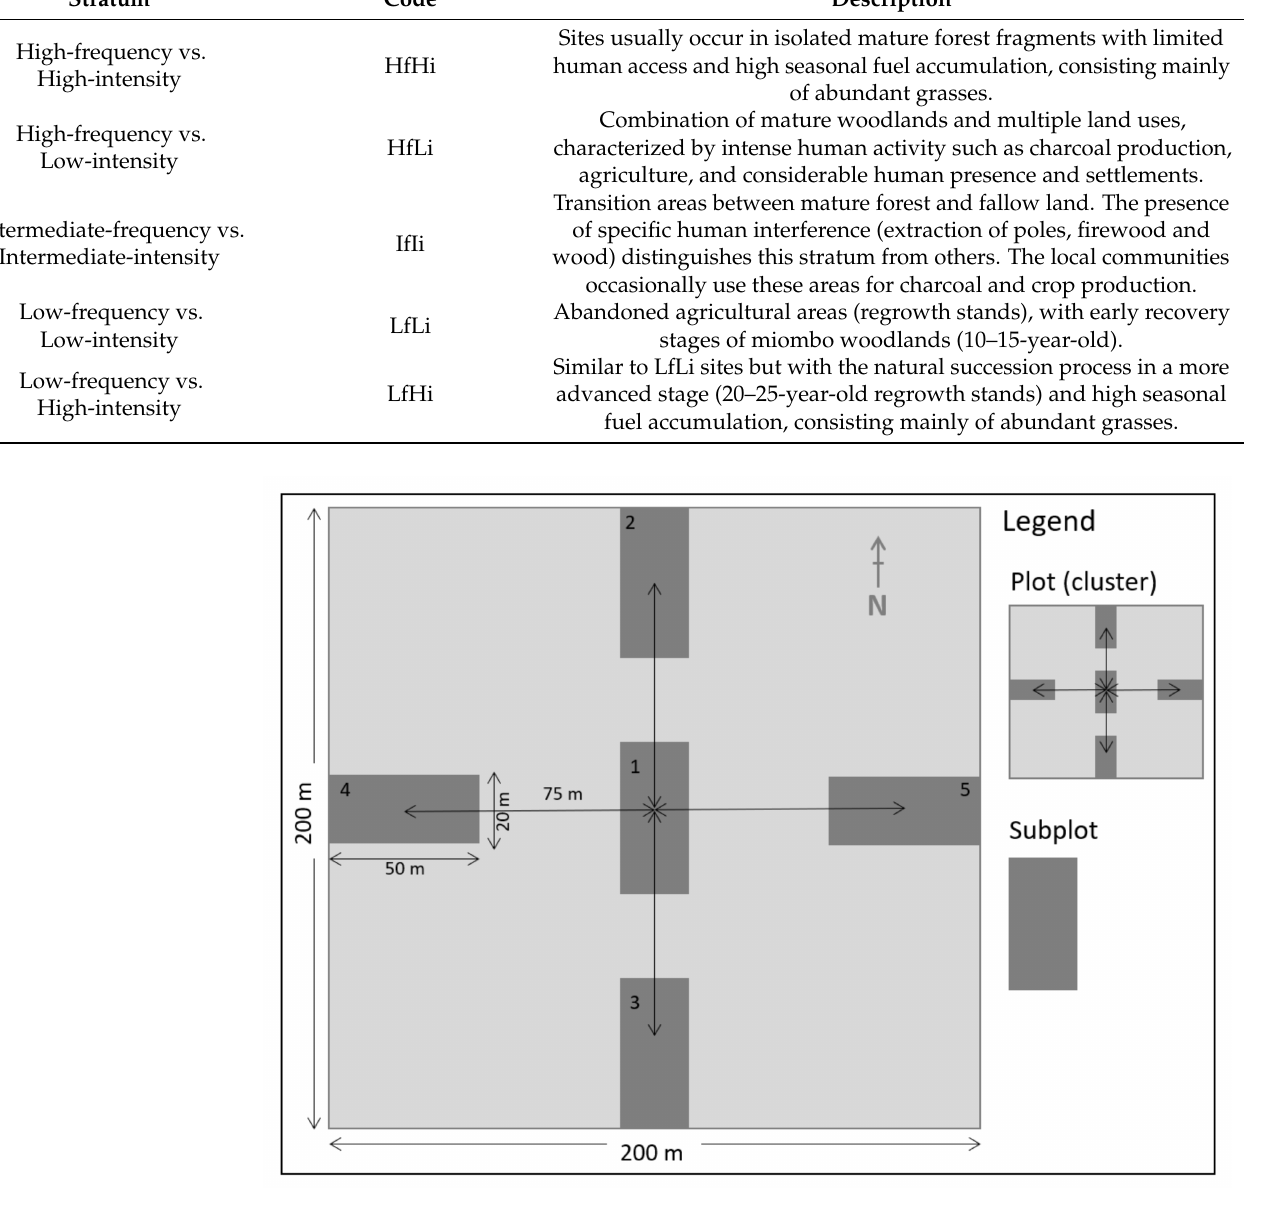
Figure 2. Scheme of the cluster used for field data